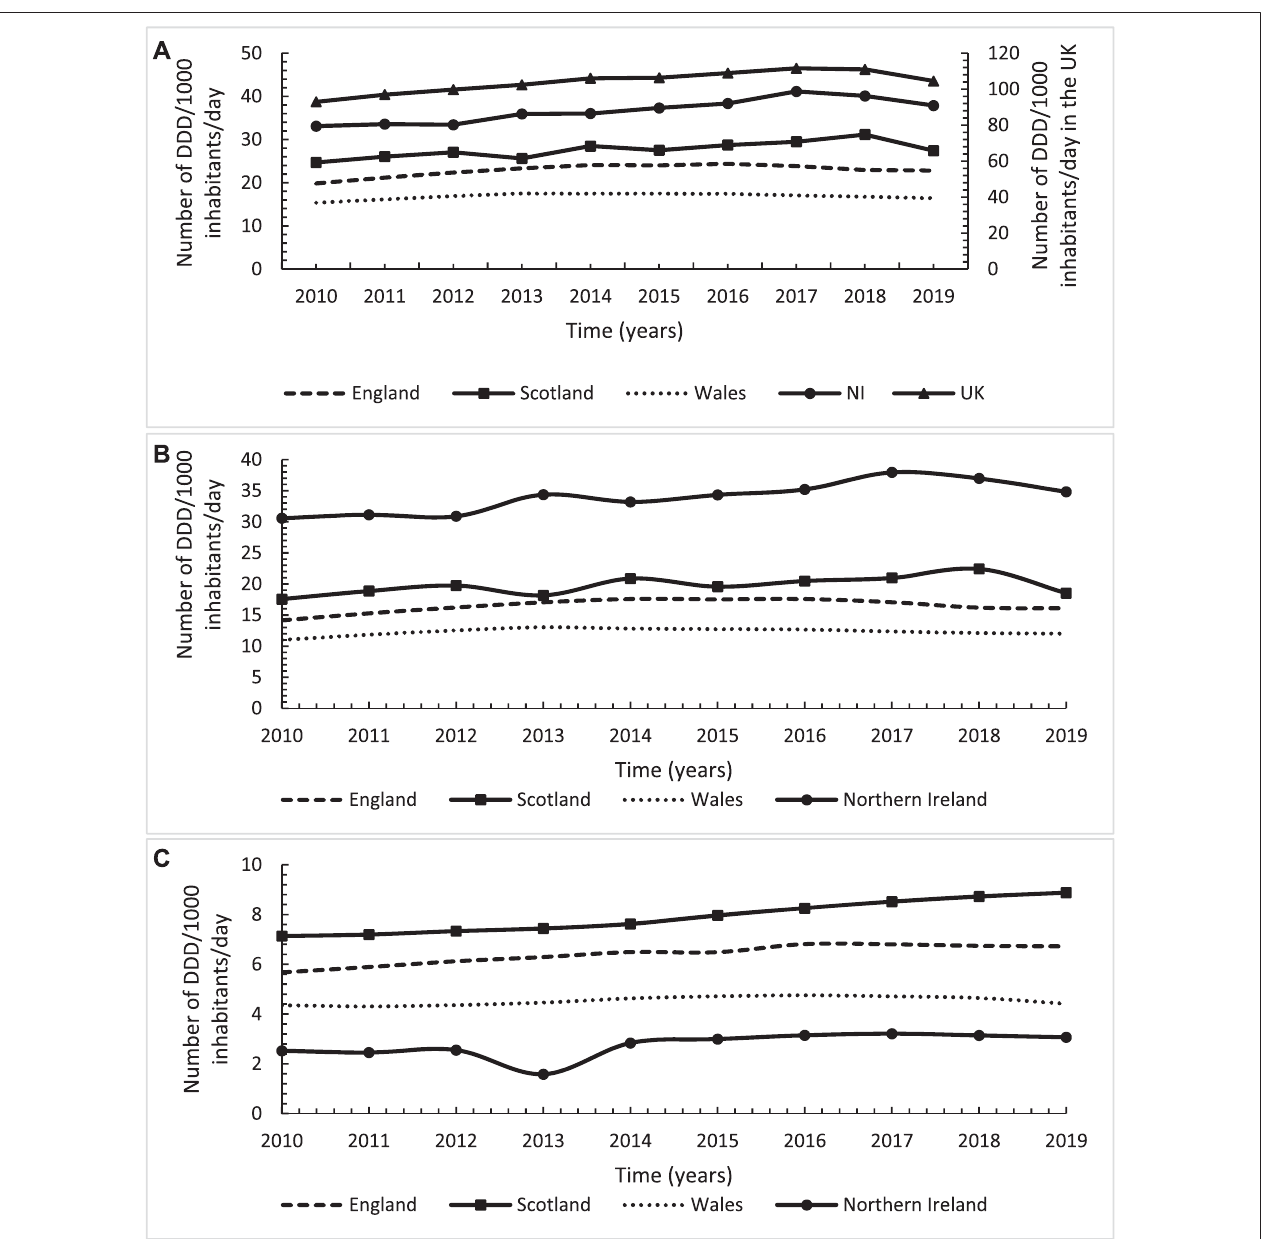
FIGURE2| Annualutilisationtrendsinnumberofde fi neddailydoses/1,000inhabitants/dayforopioidsacrossEngland,Scotland,WalesandNorthernIrelandover the study period from 2010 to 2019; (A) : Total opioids; (B) : Strong opioids; (C) : Weak opioids.